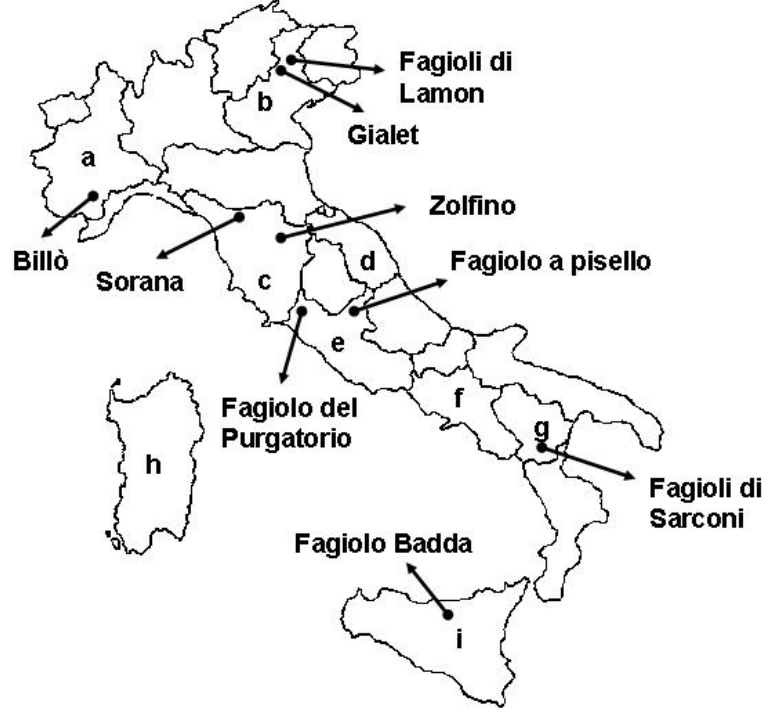
Figure 2. Map of Italy with provenance of some common bean landraces. (a) Piedmont; (b) Veneto; (c) Tuscany; (d) Marche; (e) Lazio; (f) Campania; (g) Basilicata; (h) Sardinia; (i) Sicily. Arrows indicate the landrace cultivation